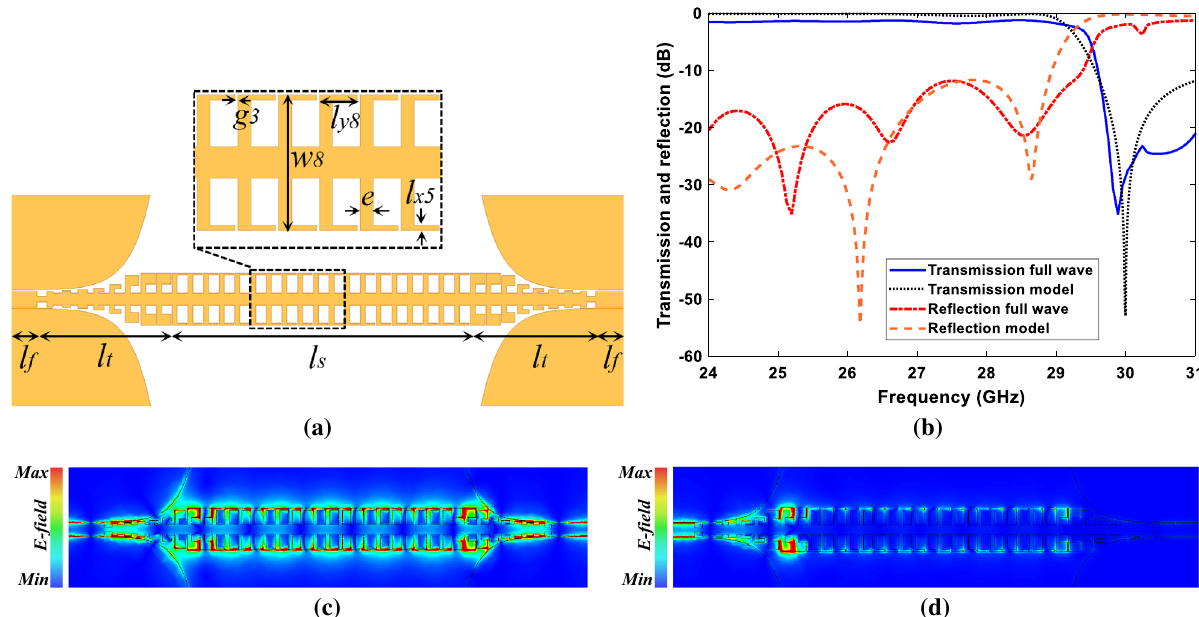
Figure 4. The proposed SSPPs TL. ( a ) Top view of the proposed SSPPs TL. Detailed dimensions are determined as: g 3 = 0.05, w 8 = 2.43, e = 0.225, l x 5 = 0.1, l y 8 = 0.43 (all dimensions are in mm ). ( b ) Transmission and reflection coefficients of the lossless SSPPs TL from equivalent circuit model compared with full wave simulation. ( c ) Simulated electric field distributions of the proposed at the frequency of 28 GHz and ( d ) 30 GHz. CST microwave studio 2020 (https:// www. 3ds. com/ produ cts- servi ces/ simul ia/ produ cts/ cst- studio- suite/) and MATLAB 2021 (https:// www. mathw orks. com/ produ cts/ matlab. html) were used to generate this an efficient conversion from the quasi TEM mode of the CPW line to SSPP TM mode, the width of unit cells are gradually increased and altered to L-shaped configuration. Additionally, the flaring grounds with exponential outline are employed to smoothly omit the metallic ground planes in both sides. According to the Fig. 3, the exponential curve of ground planes can be determined by starting point ( x 1 , y 1 ) and ending point ( x 2 , y 2 ), and it can be optimized to have a good matching between the CPW line and the SSPP TL. The parameters W f and g 1 shown in Fig. 3 are chosen 0.715 mm and 0.05 mm respectively to get 50-ohm impedance for the CPW line. The detailed dimensions of other parameters were given in Fig. 3. Figure 4a illustrates our proposed SSPPs TL on a 0.2 mm thick dielectric substrate RO4003 with dielectric constant of 3.55 and loss tangent of 0.002. The line consists of three concatenated parts, which are two 50-ohm CPW line on the left and right sides with length of l f , two mode convertors on the both sides with length of l t , and groundless SSPPs TL with length of l s . The length of l s was set to 13.4 mm equal to 1.25 of wave-length at 28 GHz in free space. The designed 50-ohm CPW line and mode convertors, dimensions were preceded in Fig. 3, have been utilized to attain SSPP TM mode for feeding SSPPs part. To predict transmission and reflection coefficients of the SSPPs line, the suggested circuit model in Fig. 1b comes in handy to analytically model corrugated metals with L-shaped grooves with different width from w 4 to w 8 .Furthermore, for the rest of corrugations with width of d 1 , d 2 , and w 1 to w 4 , CPW lines with curvy ground planes were considered for the modelling. For instance, the corrugation with width of w 2 can be modelled as a CPW line with a gap between maximum and minimum distance of central conductor to its curvy ground. A similar approach reported in previous studies has been employed as a starting point for modelling of the SSPP TL 42,43 . For the 50 ohm CPW line ( W f ) and a part of transition ( W 1 , d 1 , W 2 , d 2 , and W 3 ), eight CPW lines with different distances to the ground planes on the sides were used. The rest of transition part was modelled like the SSPP line. Then the model with this approach was optimized to have similar S-parameters obtained from the full wave simulation. According to the Fig. 1b, values of the circuit components for the proposed one unit cell of the SSPP TL are: L p 1 = 0.05 nH, L p 2 = 0.09 nH, L